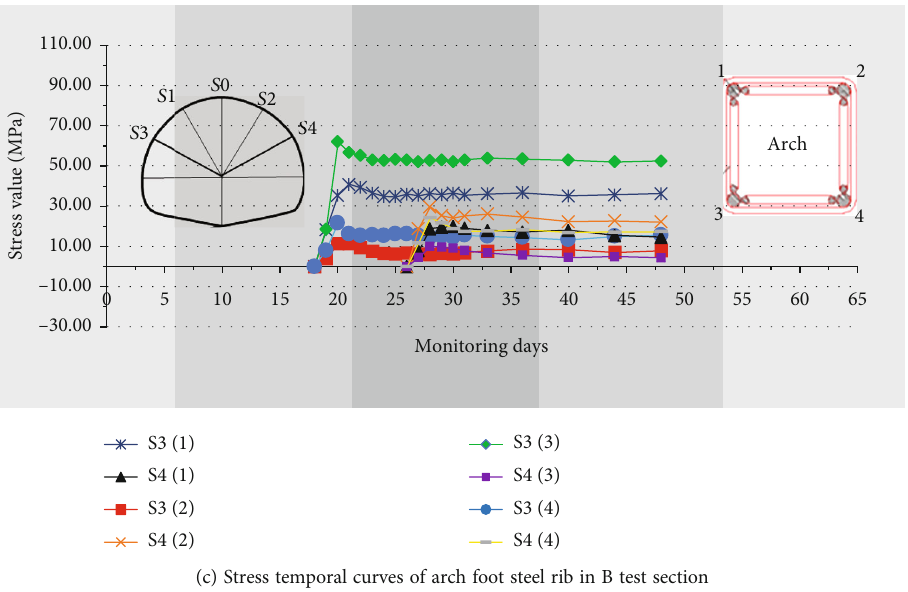
(c) Stress temporal curves of arch foot steel rib in B test section Figure 4: Stress temporal curves of arch foot steel rib.